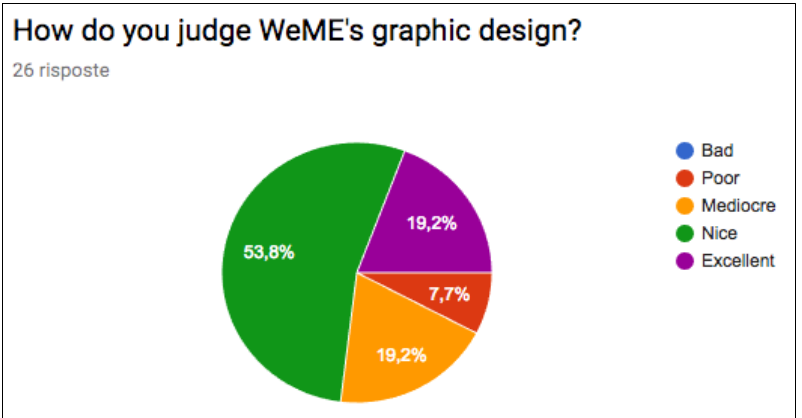
Figure 18. Opinion on the graphics of the